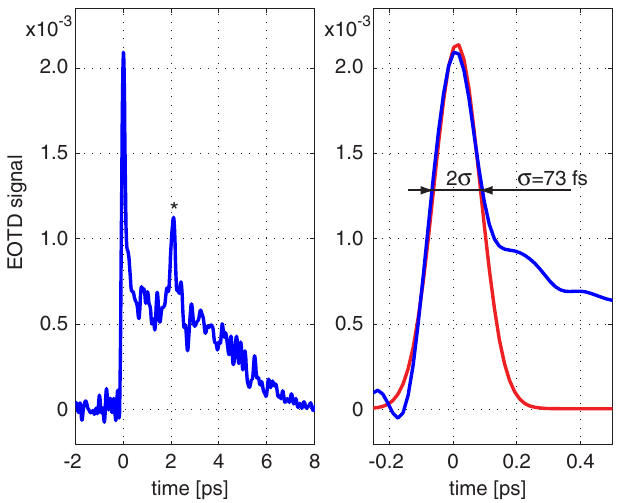
FIG. 13. (Color) EOTD signal of a compressed electron bunch using a 100 (cid:1) m thick GaP crystal and at an angle (cid:6) ¼ 1 (cid:3) of the half-wave plate. The signal is background subtracted and nor- malized. The peak marked with an asterisk is caused by internal reflection in the GaP crystal. The right panel shows the leading peak on an expanded time scale; the red line shows a Gaussian fit to the leading